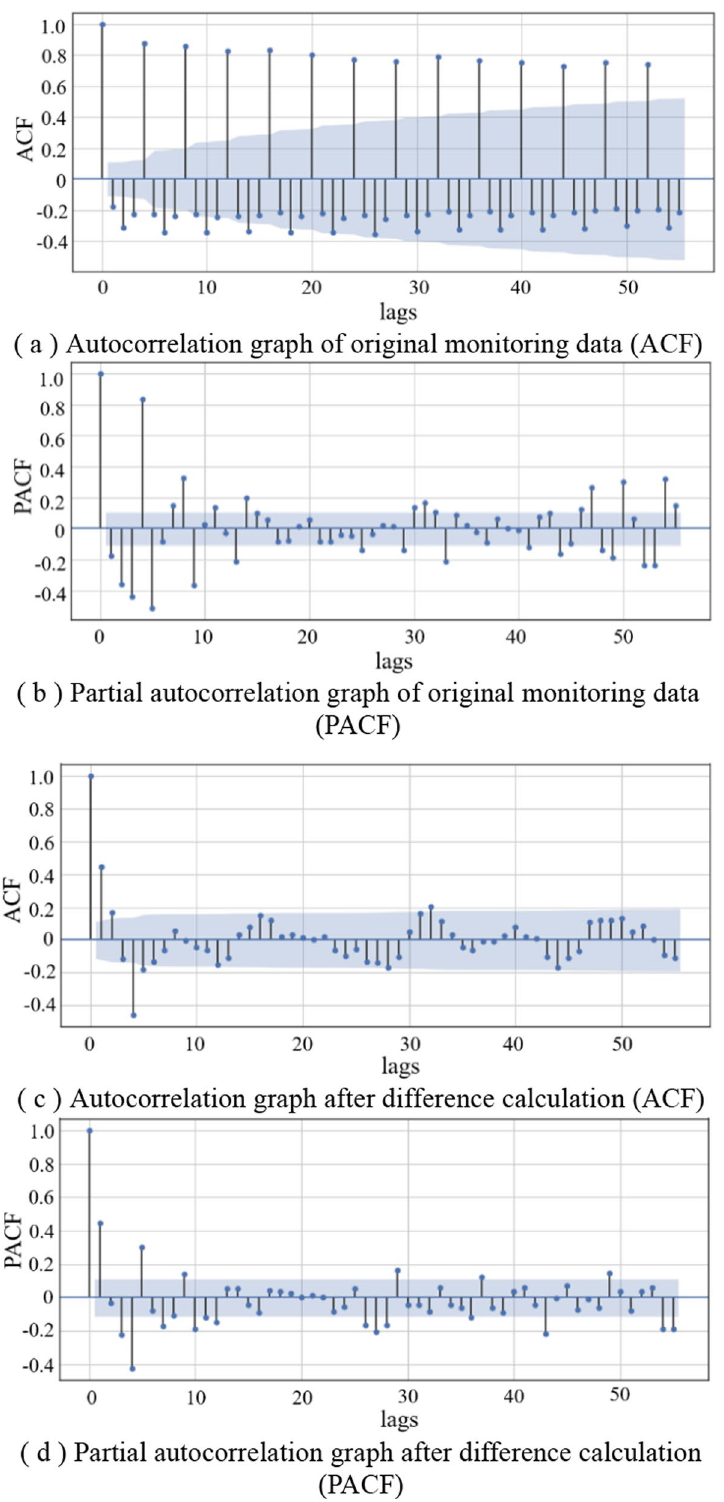
Fig. 9 Autocorrelation and partial autocorrelation graphs of the monitoring data before and after differential